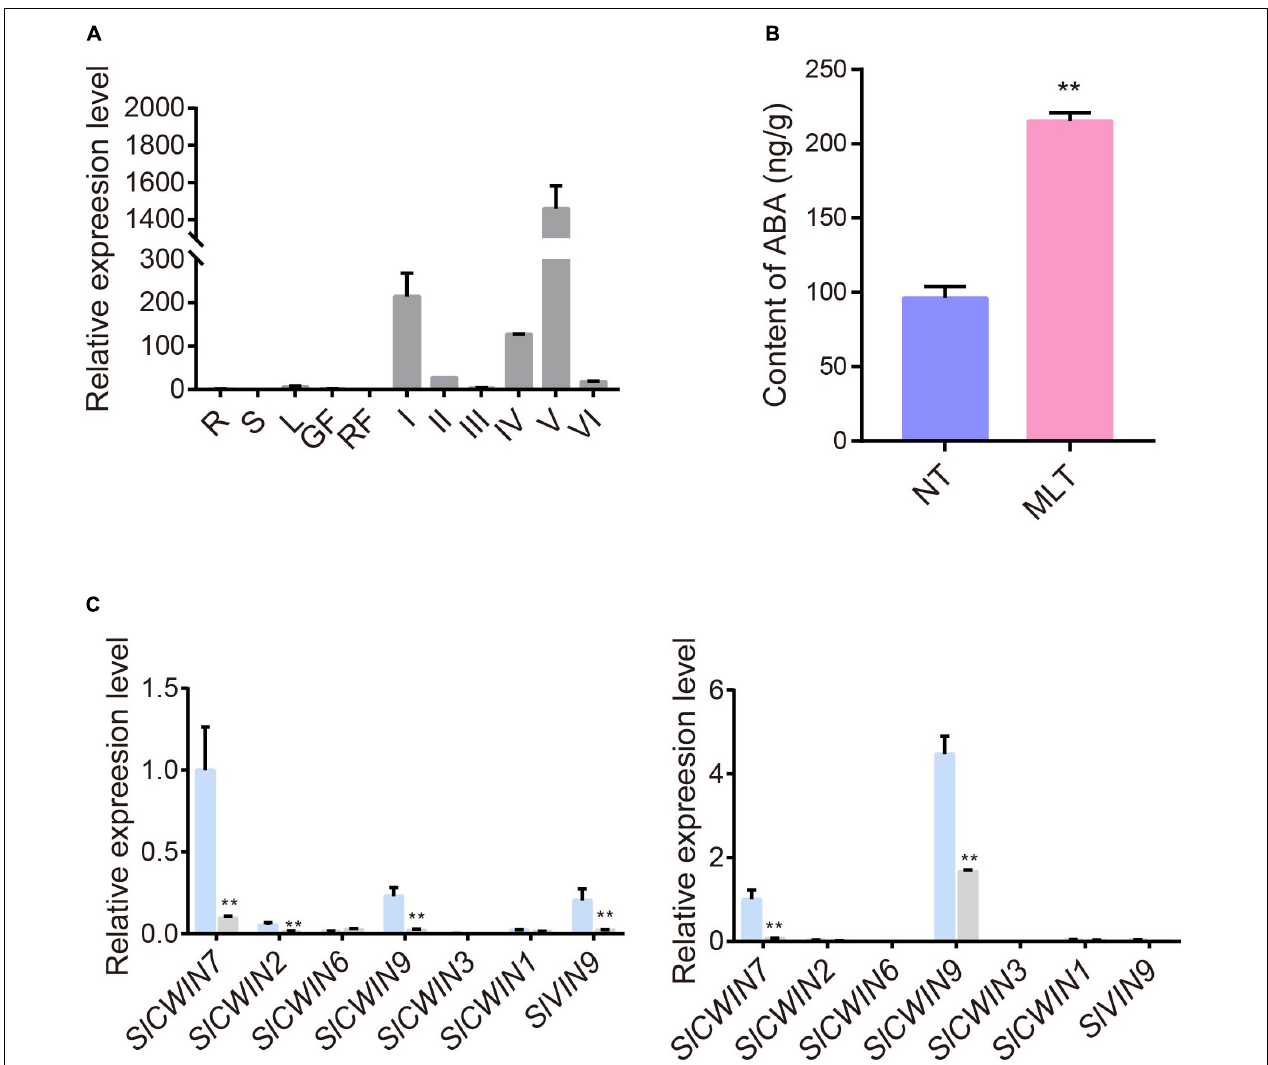
FIGURE 7 | The expression profiles of SlABCG31 and ABA levels in anther under NT and MLT conditions. (A) qPCR analysis of SlABCG31 in various tissues of tomato, especially in anther at different stages. The genes expression levels normalized to Ubiquitin expression are shown relative to root set to 1. R, root; S, stem; L, leaf; GF, green fruit; RF, red fruit; I, anther at microspore mother cell stage; II, anther at tetrad stage; III, anther at early uninucleate stage; IV, anther at late uninucleate stage; V, anther at binucleate stage; VI, anther at mature pollen stage. Each value is the mean ± SD ( n = at least three biological replicates with 15 plants